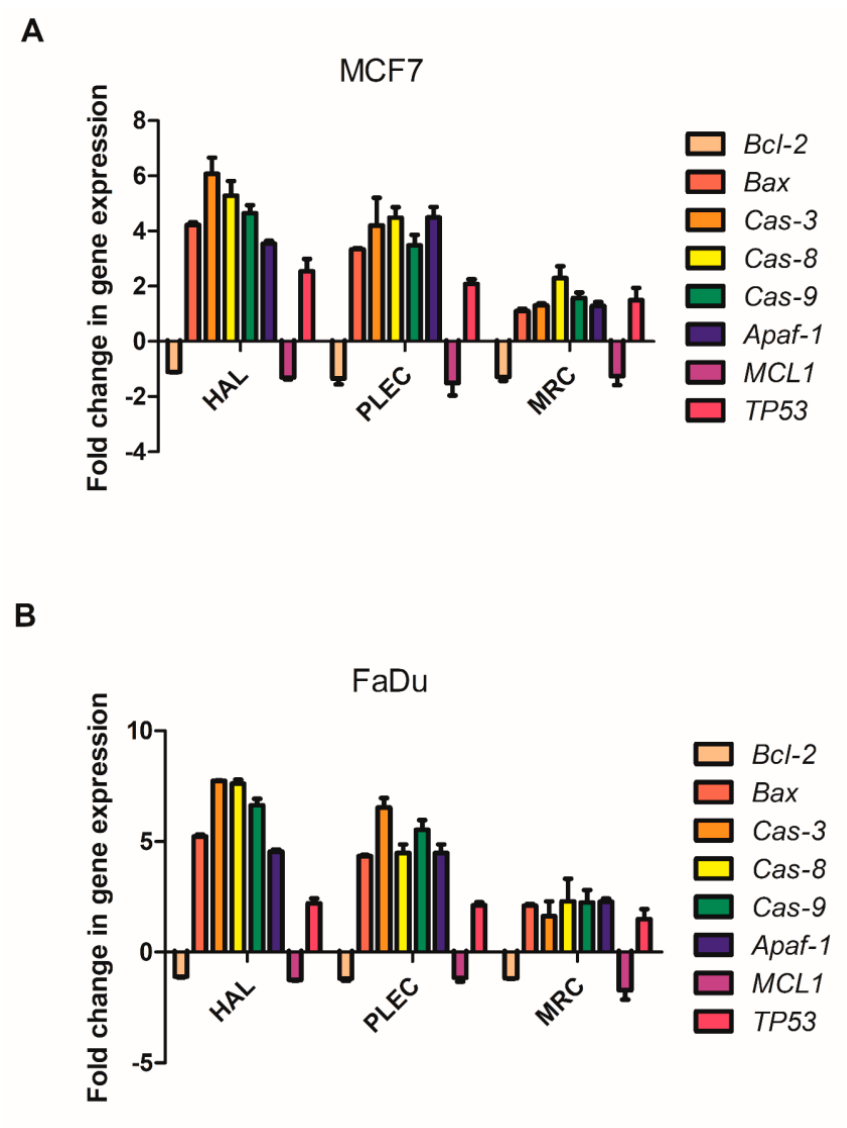
Figure 8. ( A , B ) . Gene expression ( Bax, Bcl-2 Cas-3, Cas-8, Cas-9, Apf-1 MCL1 and TP53 ) for MCF7 (panel A ) and FaDu (panel B ) cell lines after 24 h treatment with tested compounds. Data is presented as fold change in cells treated with HAL, PLEC and MRC compared to untreated cells, in which the expression level was taken as 1. The mean values ± SD (n = 3).